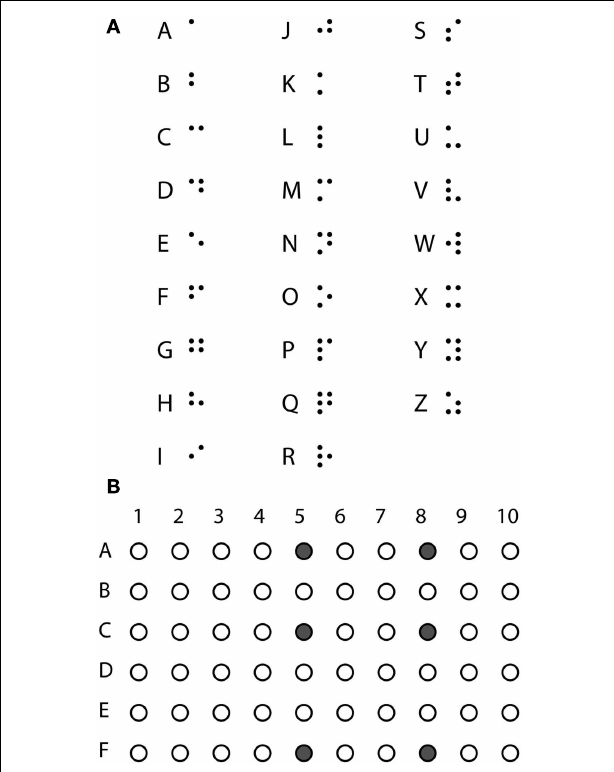
FIGURE 2 | Stimulating braille. (A) The braille alphabet. (B) Six electrodes forming the basis of the braille stimulation used in the experiment.